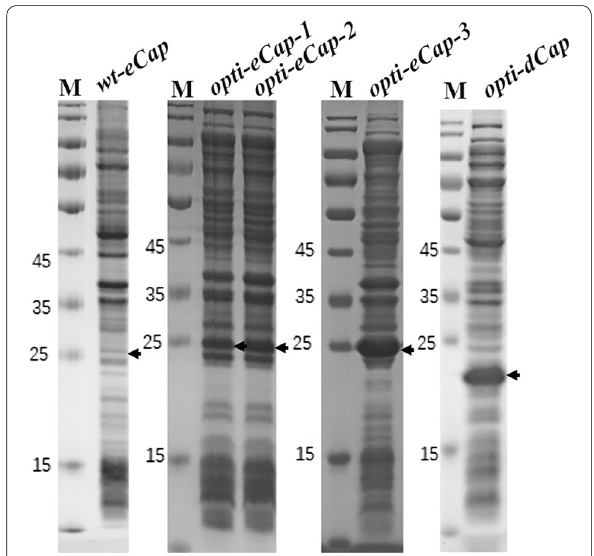
Fig. 2 Preparation of eCap and dCap produced in E. coli . SDS‑PAGE of protein preparation and staining with coomassie